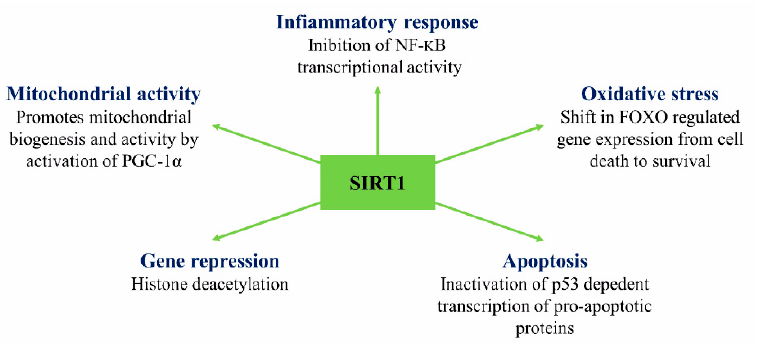
Figure 6. Nuclear activities of SIRT1. The regulation of gene expression by SIRT1 deacetyltransferase activity allows for the activation and inhibition of signaling pathways involved in numerous cellular functions.